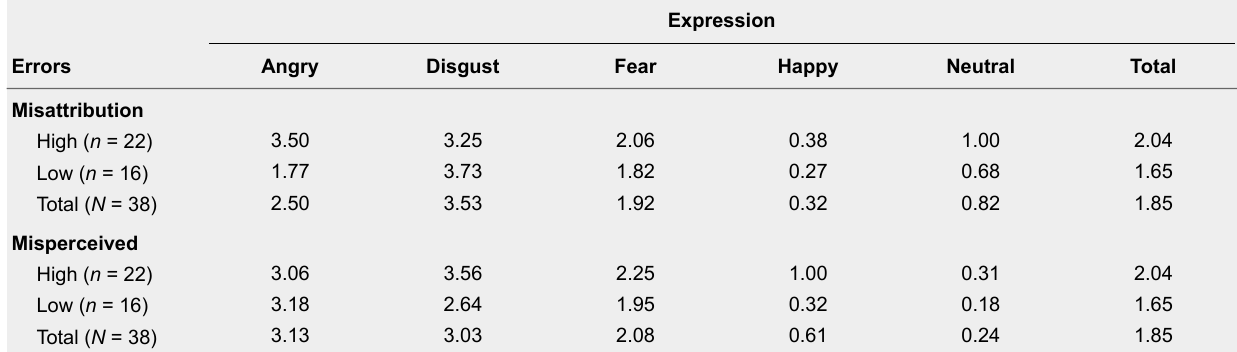
Averaged Facial Expression Misattributed and Misperceived Identification Errors as a Function of Facial Expression Type and Physically Aggressive